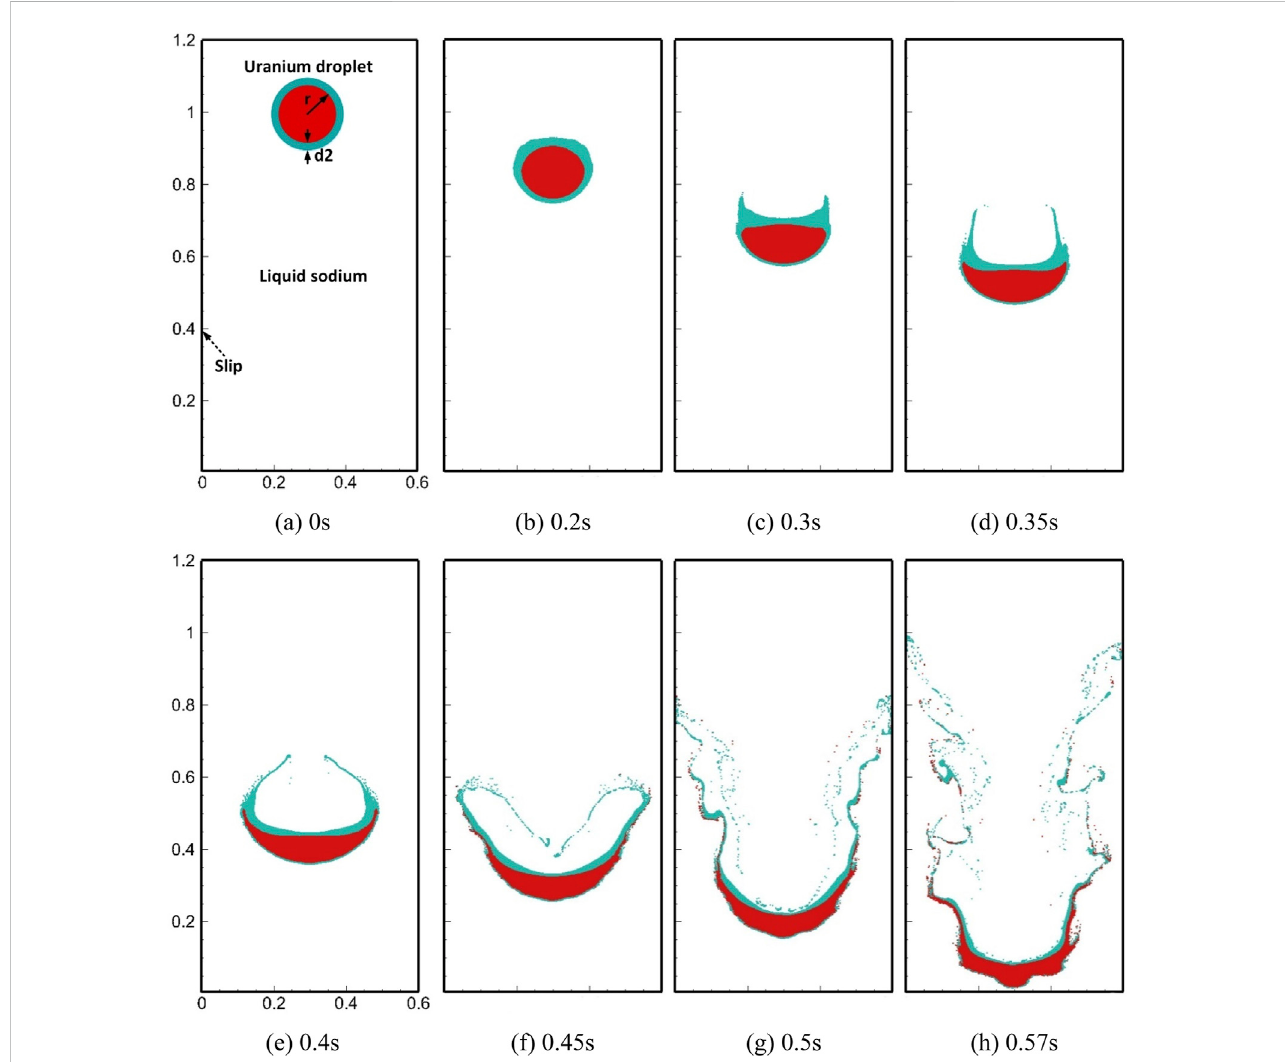
FIGURE 12 Initial setup and images in the interaction between U coated with Stainless steel fi lm with thickness of 0.02 m and